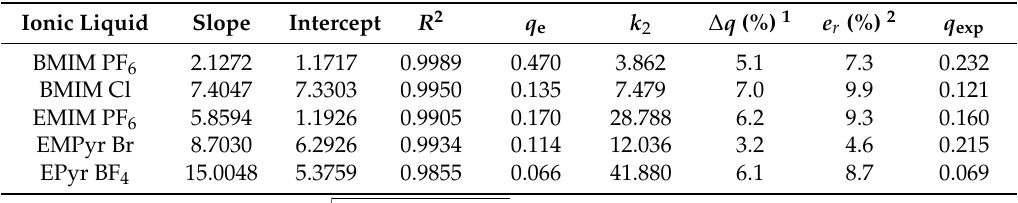
Table 4. Kinetic parameters for ionic liquids adsorption onto silica gel at 25 ˝